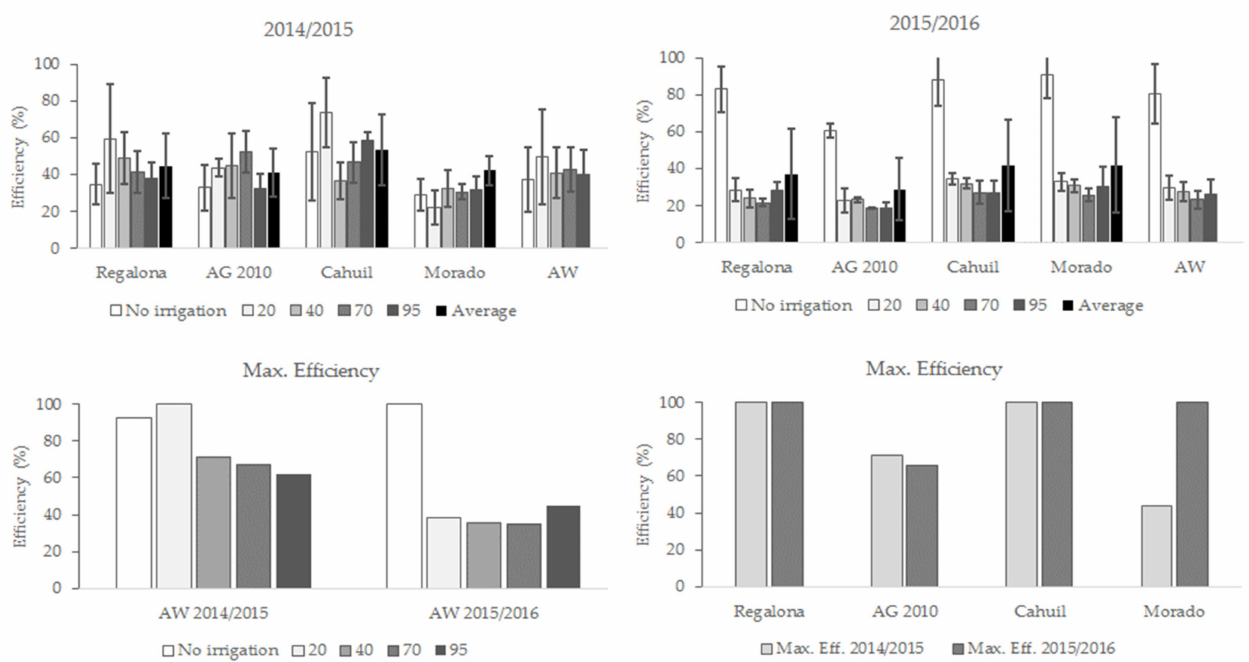
Figure 7. Average technical efficiency in multiproduct in quinoa genotypes subjected to different water deficit conditions in the 2014/2015 and 2015/2016